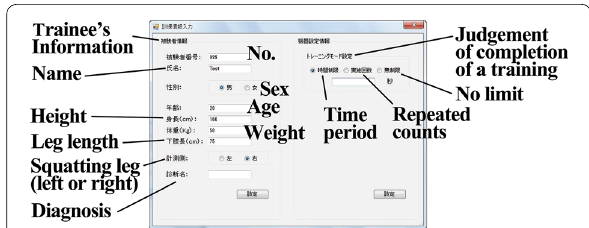
Fig. 8 Input screen for the trainee’s data